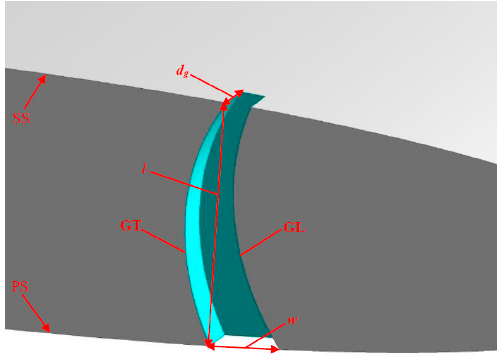
Figure 34. Sketch map of C groove on blade tip [82]. GT: groove leading edge; GL: groove trailing edge.